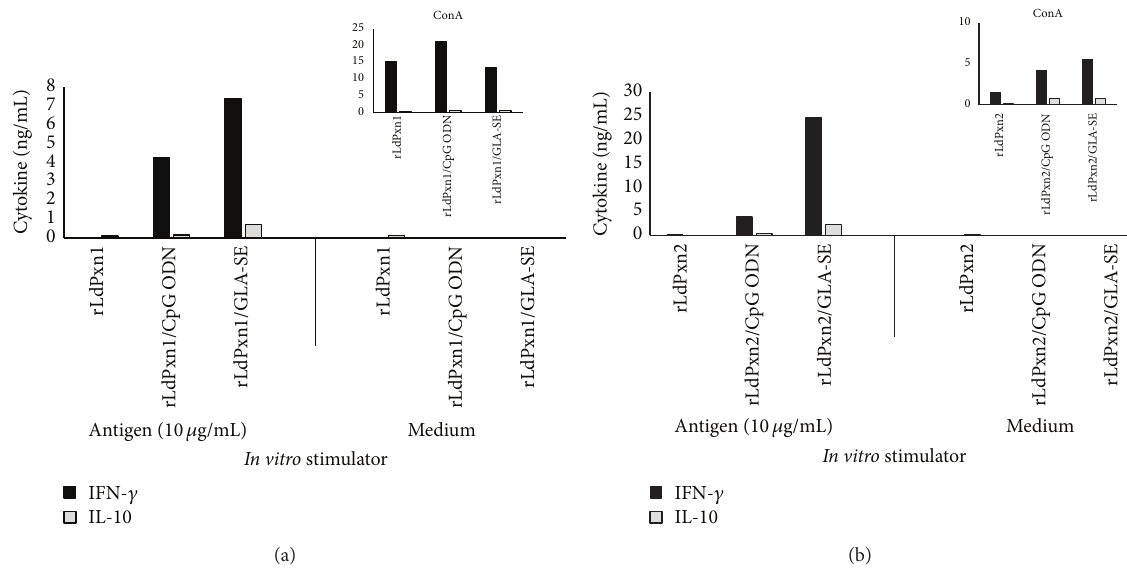
Figure 4: Cytokine responses in lymph node cells of rLdPxn1 and rLdPxn2 immunized mice. Mice were immunized subcutaneously three times at three-week intervals with rLdPxn1 or rLdPxn2 with or without CpG ODN or GLA-SE. Four weeks after the last immunization, cells from pooled lymph nodes were stimulated in vitro with the respective antigen (10 𝜇 g/mL) or ConA (5 𝜇 g/mL). The release of IFN- 𝛾 and IL-10 in mice immunized with rLdPxn1 or rLdPxn2 was measured in supernatants after 72 hr of in vitro stimulation at 37 ∘ C. Results are